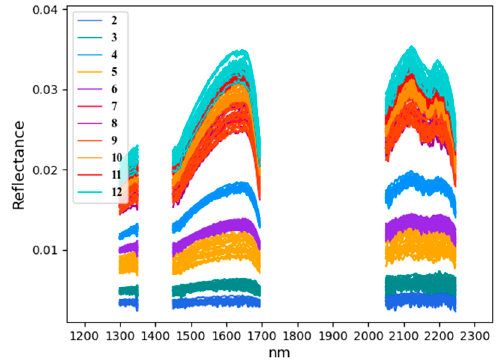
Figure 9. Real spectral feature data curves.